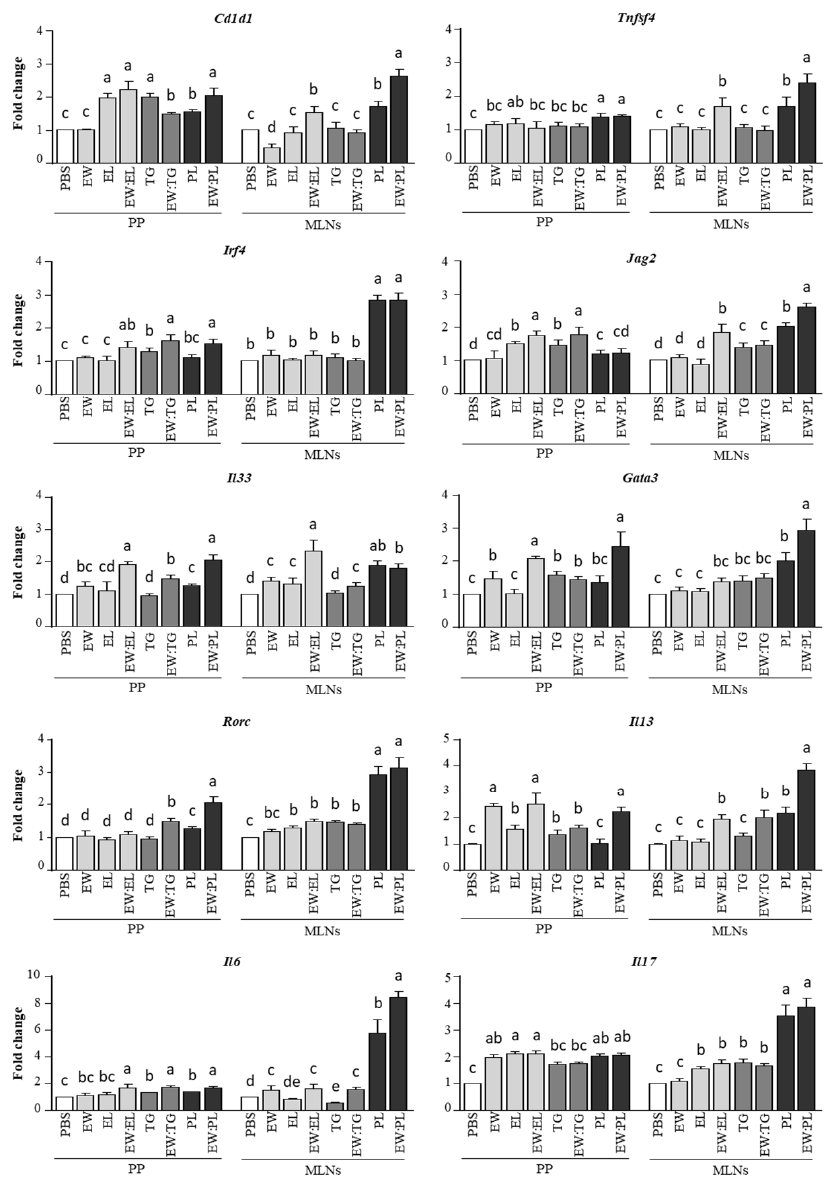
Figure 5. Relative gene expression of Cd1d , Tnfsf4, Irf4, Jag2, Il33, Gata3, Rorc, Il13, Il6 , and Il17 , determined in the Peyer’s patches (PP) and mesenteric lymph nodes (MLN) of mice intragastrically administered PBS, egg white (EW, 50 mg), egg lipids (EL, 60 mg), a triacylglyceride-enriched fraction (60 mg, TG), a phospholipid-enriched fraction (60 mg, PL), and their mixtures (50 mg:60 mg) with EW (respectively EW:EL, EW:TG, EW:PL) for 6 consecutive days. Gene expression was normalized to the reference gene Actb and compared with mice administered PBS. Data are expressed as means ± SEM ( n = 6). Different letters indicate statistically significant differences ( p < 0.05) among different mouse groups.